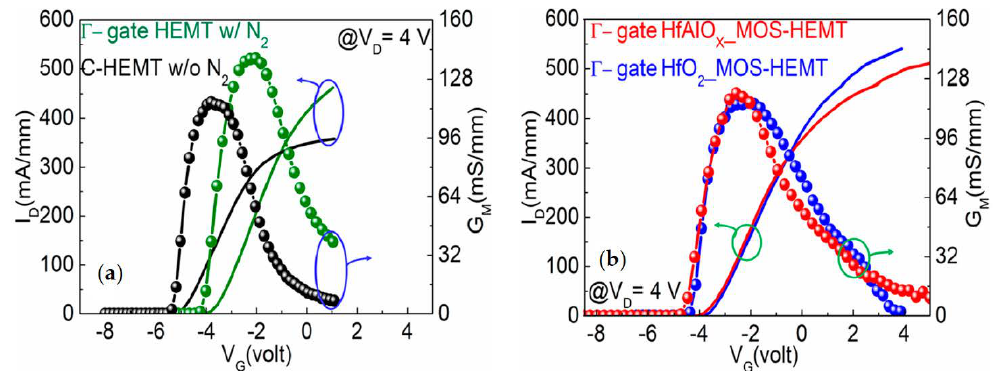
Figure 5. Comparison of transfer characteristics (I D –V G ) (@ V D = 4 V) of ( a ) Γ -gate HEMT (with the N 2 plasma treatment) and non-recessed HEMT (w/o the N 2 plasma treatment) and ( b ) Γ -gate HfO 2 and HfAlO X MOS-HEMT with the N 2 plasma treatment.